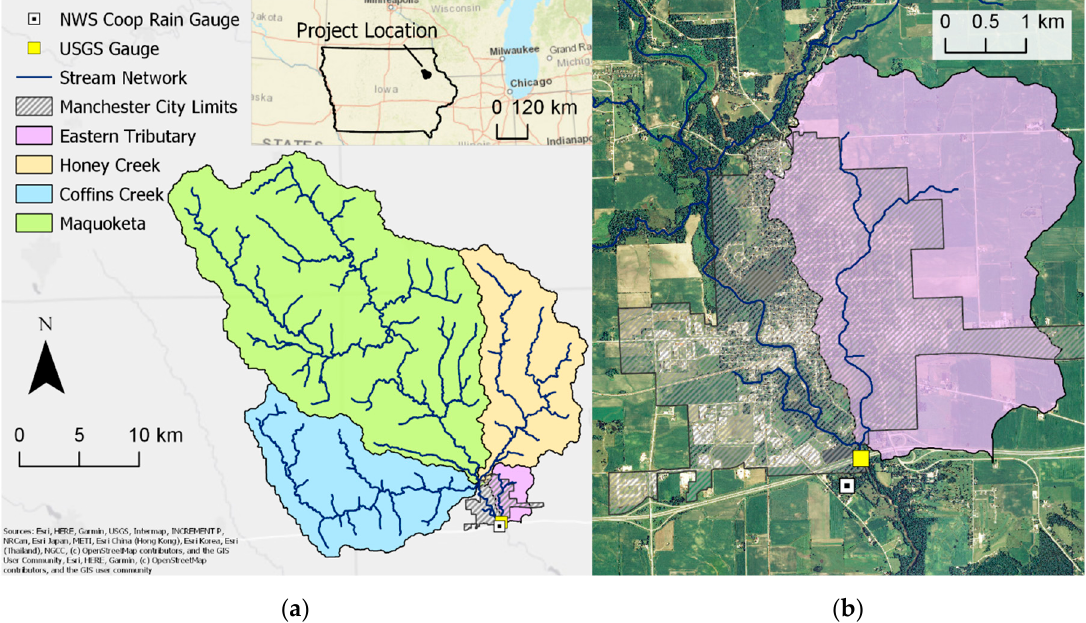
Figure 1. ( a ) The extent of the regional model was 725 km 2 of rural land in the upper Maquoketa River watershed, located in northeast Iowa. The major tributaries are Coffins Creek and Honey Creek, which drain into the Maquoketa River at the north end of the city limits of Manchester. ( b ) The extent of the local model included Manchester city limits, which are divided by the Maquoketa River. The Eastern Tributary drains into the Maquoketa River near the United State Geological Survey USGS streamflow gauge and NWS Coop rain gauge located at the model outlet.